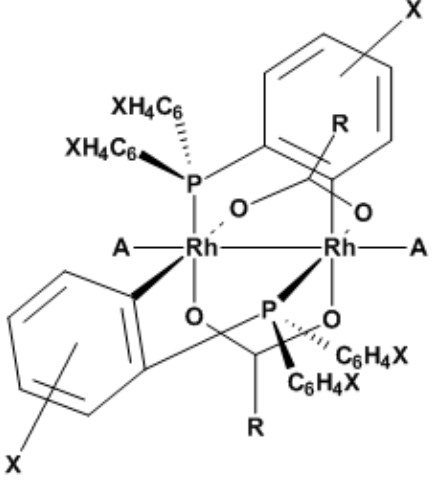
Figure 3. Chemical structure of the gasochromic binuclear rhodium